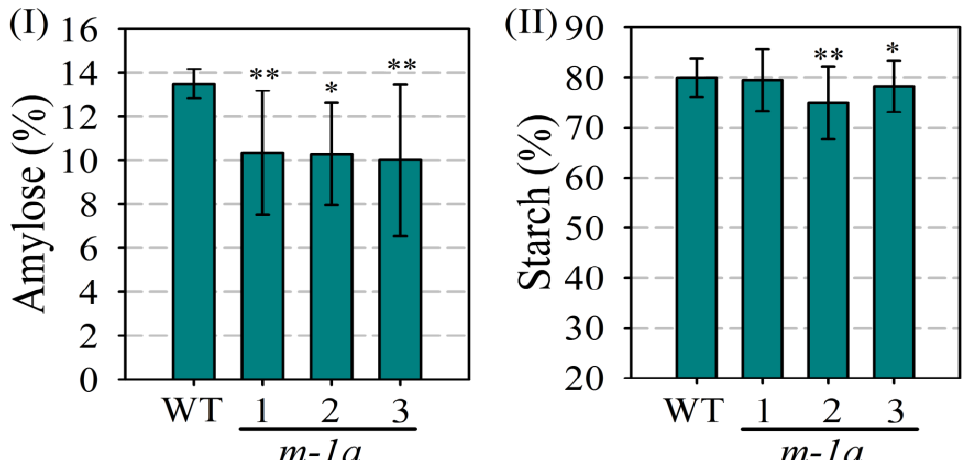
Figure 5. Comparison of the amylose and starch contents in m-1a rice and wild-type seeds. ( I ) Comparison of the amylose contents. ( II ) Comparison of the starch contents. 1–3 = m-1a rice plants. (WT = wild-type plants (‘Zhonghua 11’). Values represent the mean ± SD of triplicates. The asterisks indicate that the correlation coefficients were highly significantly different (* p < 0.05, ** p < 0.01).